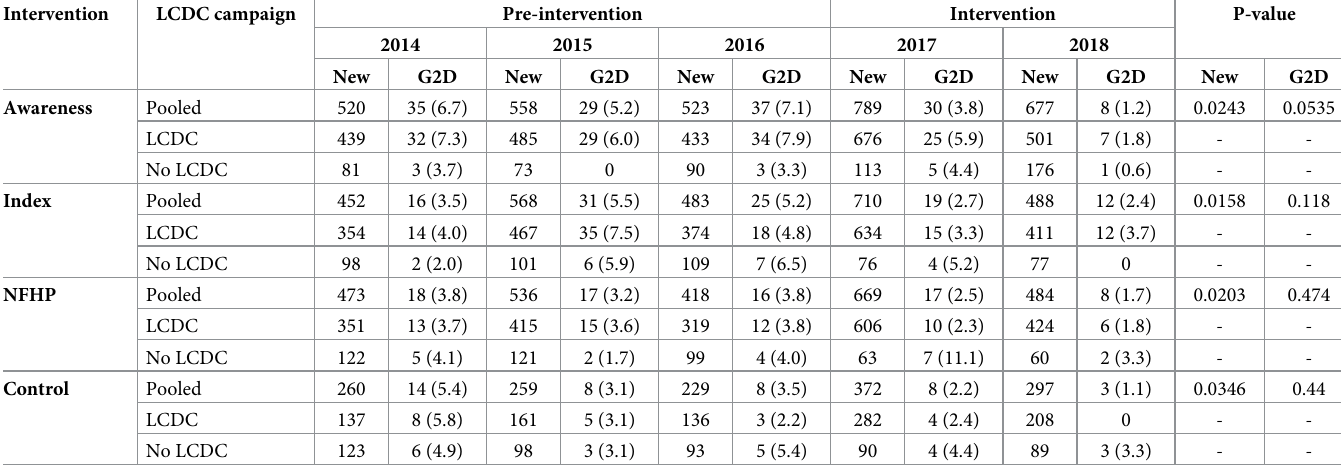
Table 5. Total number of new leprosy cases detected and percentage of G2D disability among them during intervention and pre intervention period, stratified by the LCDC campaign. Intervention LCDC